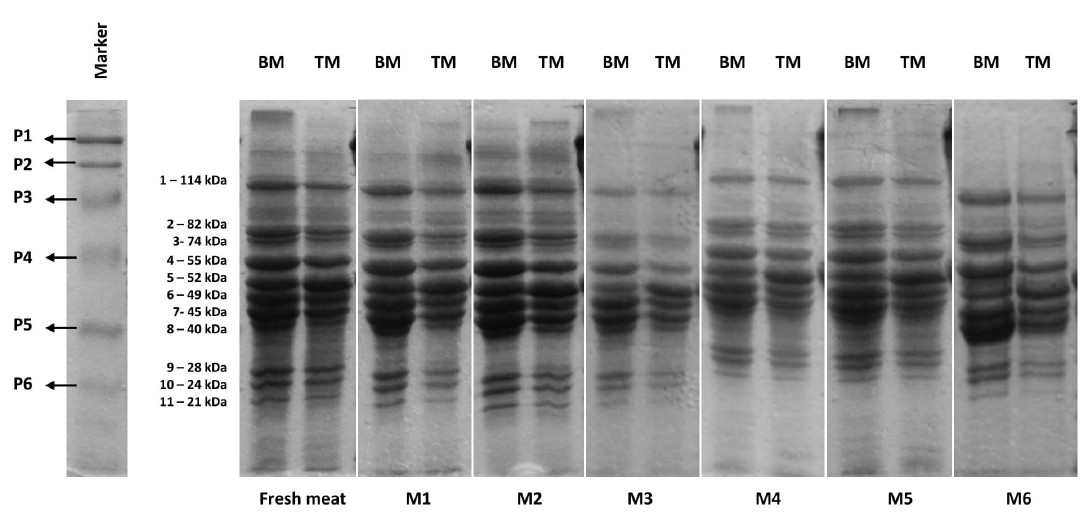
Fig. 1. Sarcoplasmic protein pattern of chicken breast and thigh meat cuts within 6 months of frozen storage (BM = chicken breast meat; TM = chicken thigh meat; FM = fresh meat; M1 = 1-month-old frozen sample; M2 = 2-month- old frozen sample; M3 = 3-month-old frozen sample; M4 = 4-month-old frozen sample; M5 = 5-month-old frozen sample; M6 = 6-month-old frozen sample; P1 = myosin (202.82 kDa); P2 = β-galactosidase (115.56 kDa); P3 = bovine serum albumin (98.22 kDa); P4 = ovalbumin (51.37 kDa); P5 = carbonic anhydrase (37.24 kDa); P6 = soybean trypsin inhibitor (29.00 kDa); P7 = lysozyme (19.75 kDa); P8 = aprotinin (6.66